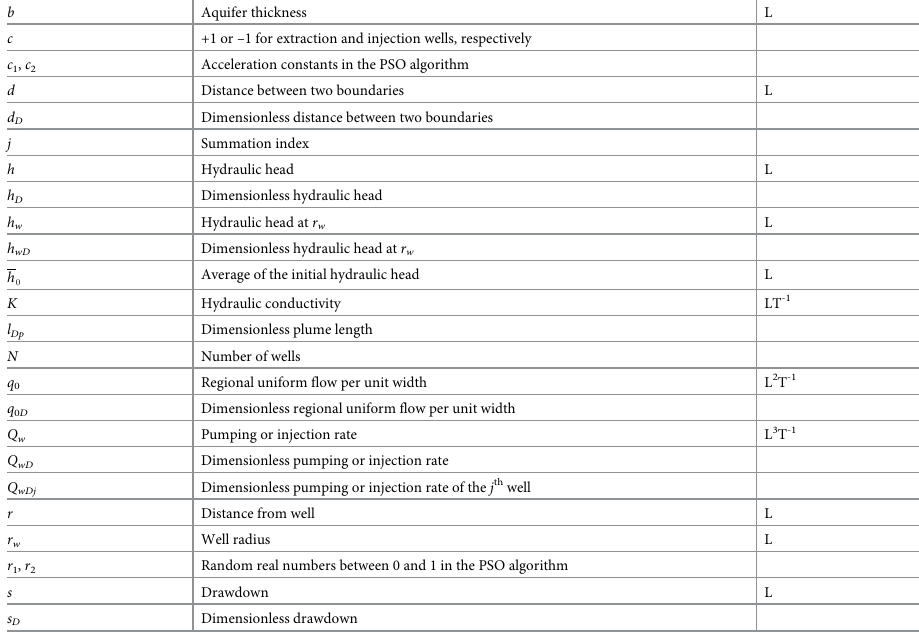
Table 5. Mathematical